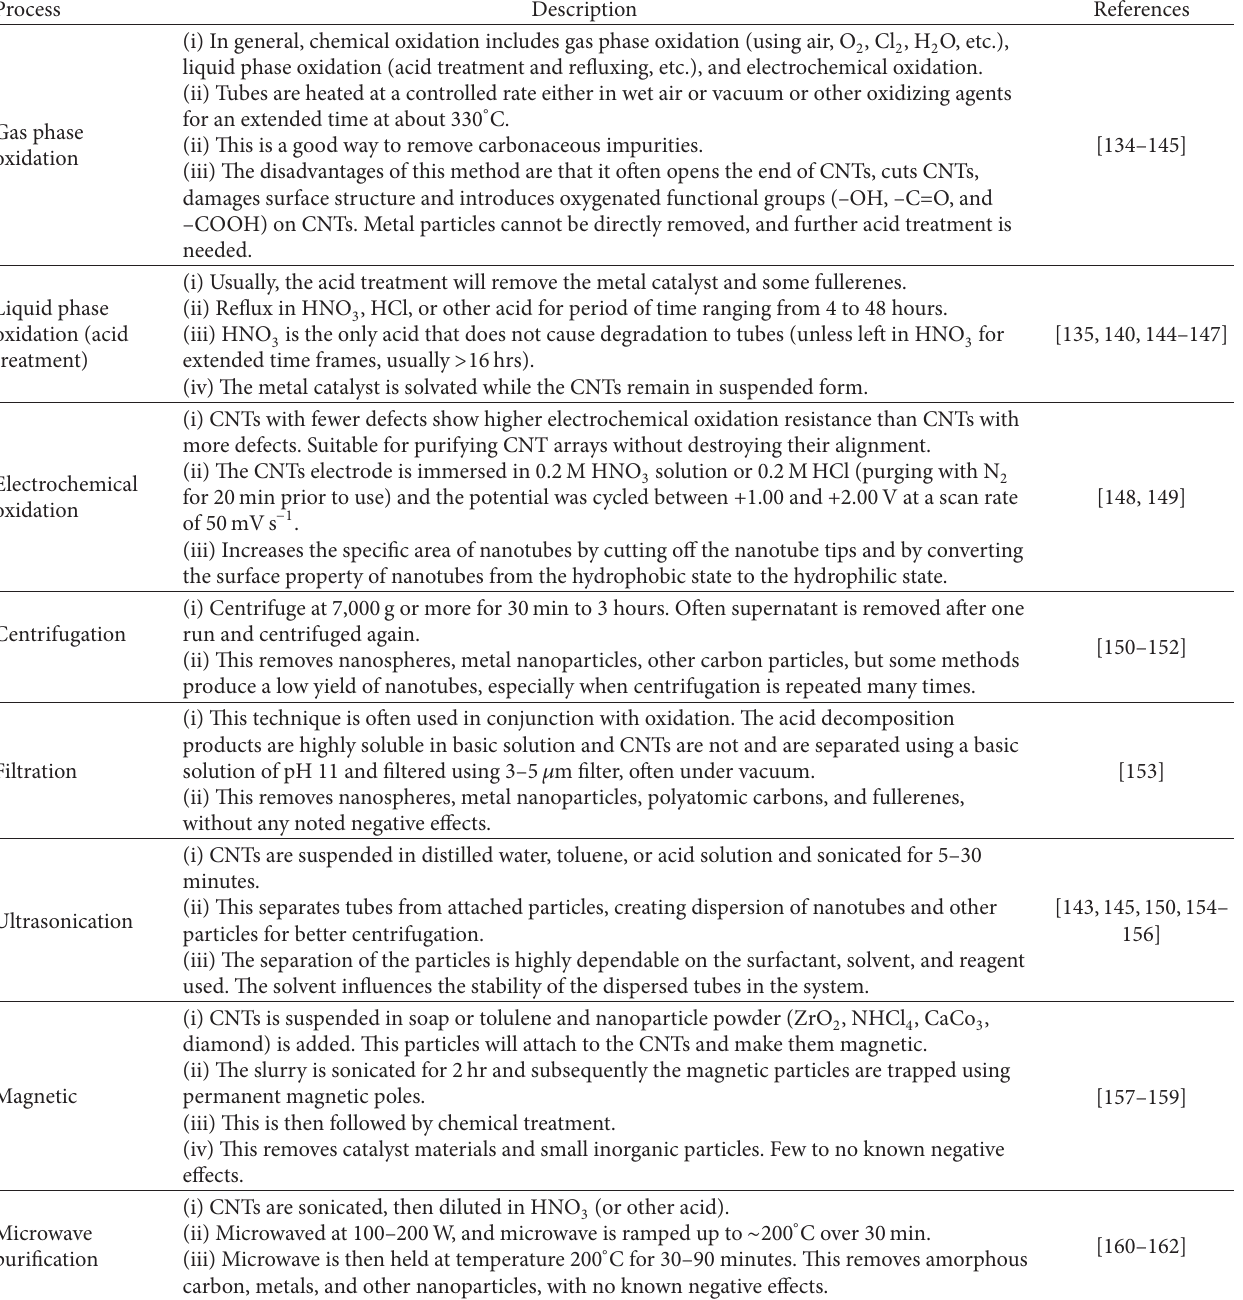
T 3: Characteristic of various processes for puri�cation of